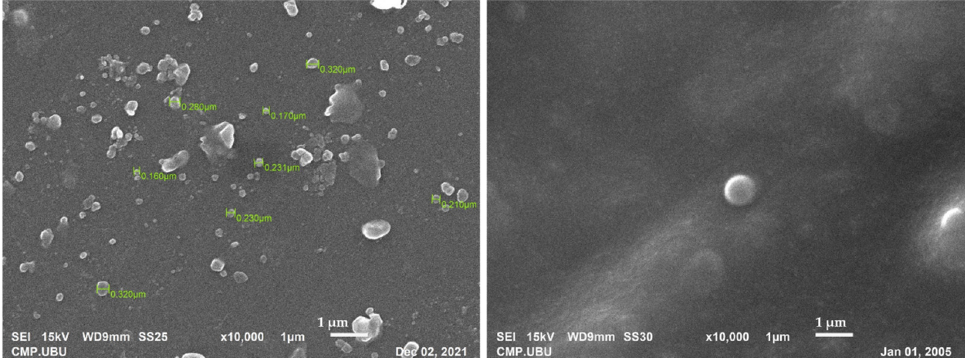
Figure 4. The representative SEM images of FLP at the magnification of 10,000×. Scale bar =